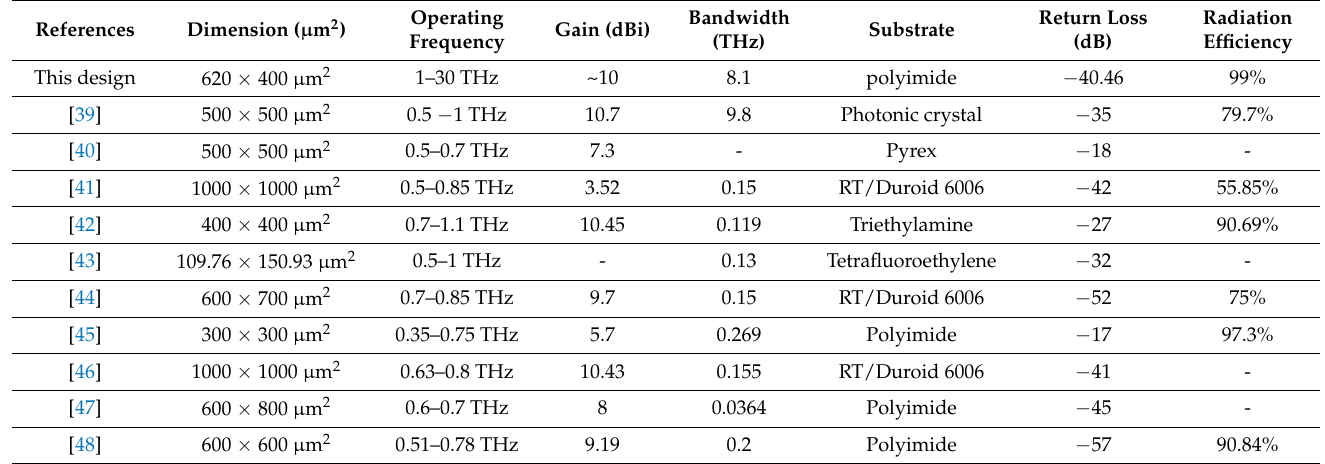
Table 4. Comparative analysis of the proposed structure with previously published